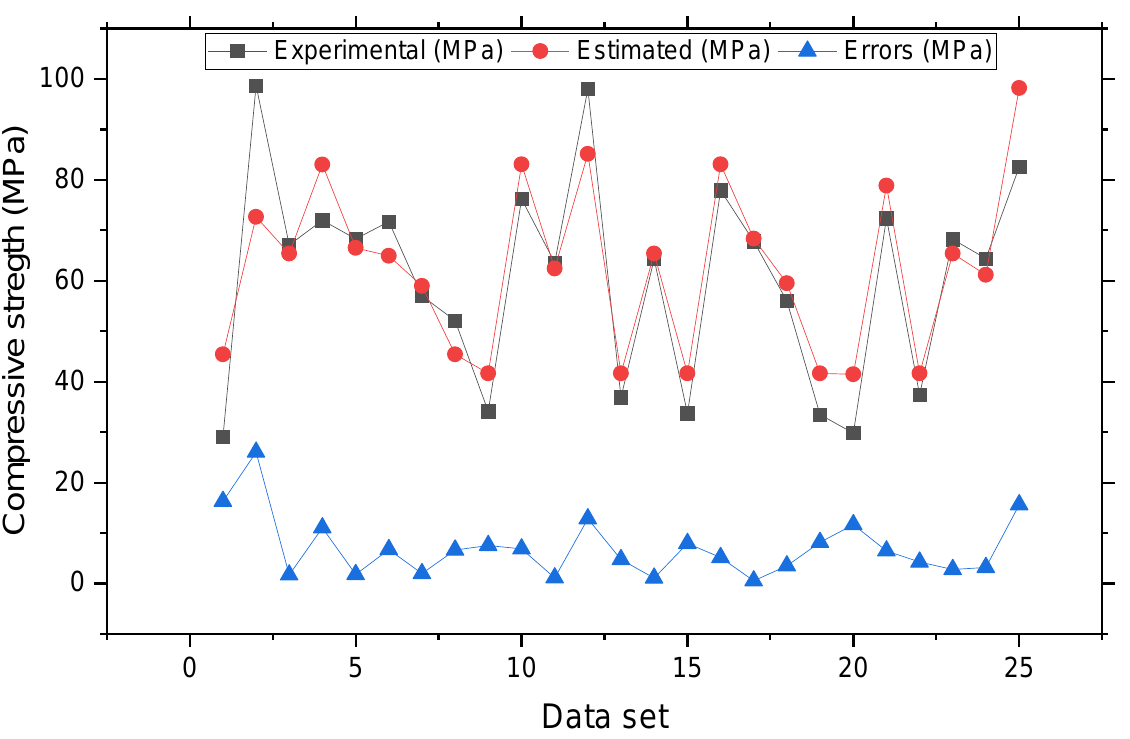
Figure 4. Experimental and estimated values and error distribution for support vector regression model.